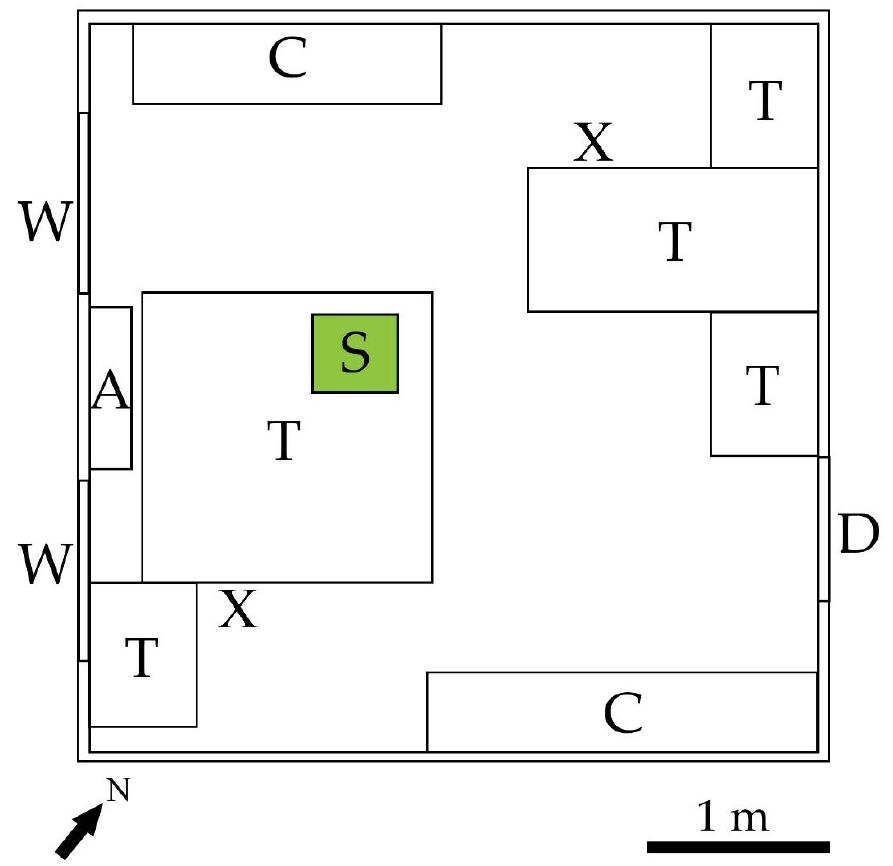
Figure 1. Representative model of the study room. S = sampler, T = table, C = closet, D = door, W = window, A = air conditioner, X = positions usually occupied by workers. The arrow in the bottom left indicates the north.